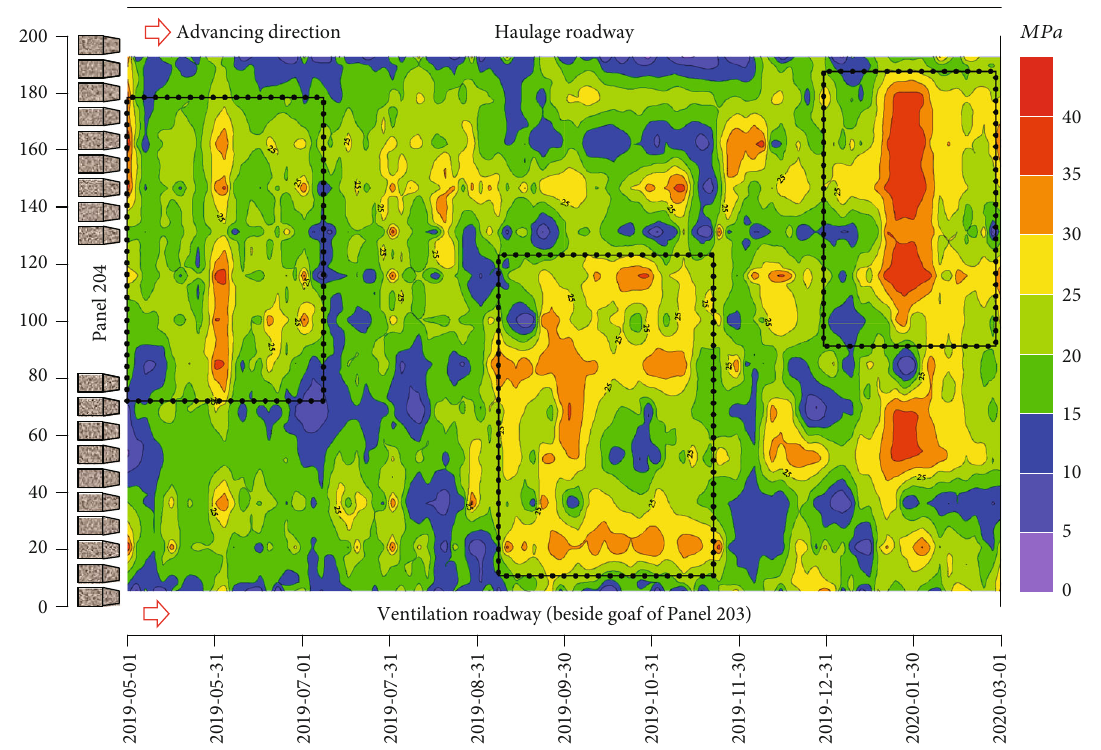
Figure 12: Working resistance of hydraulic supports in panel 204 from May 2019 to February 2020.